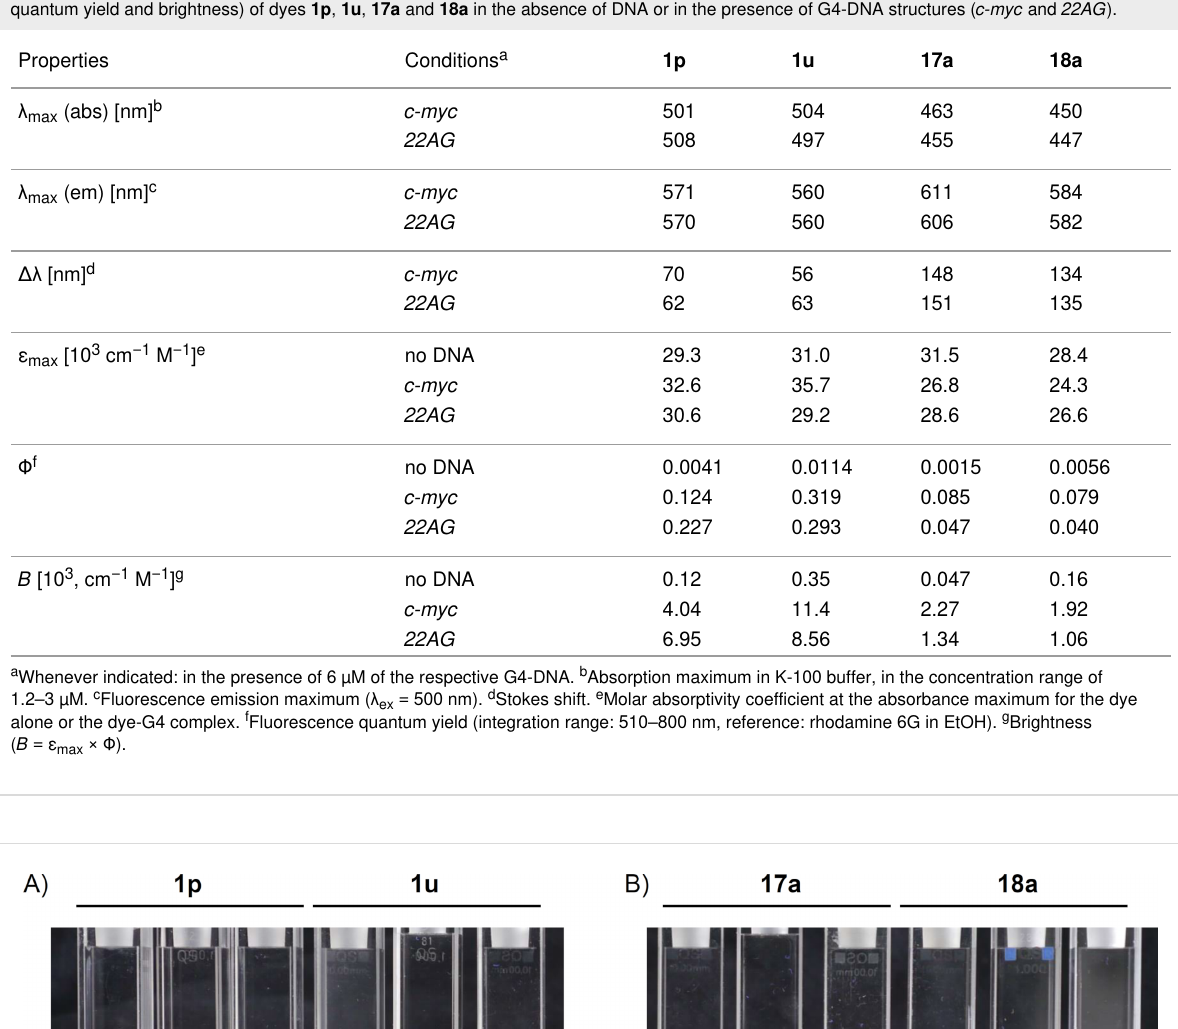
brightness data were obtained from the multiplication of the corresponding quantum yield by the molar absorptivity coefficient at absorption maxima ( ε max ) values, for dyes alone and dye–G4 complexes. The obtained data are presented in Table 3. The images of dyes in the absence and in the presence of selected DNA samples are shown in Figure 10.